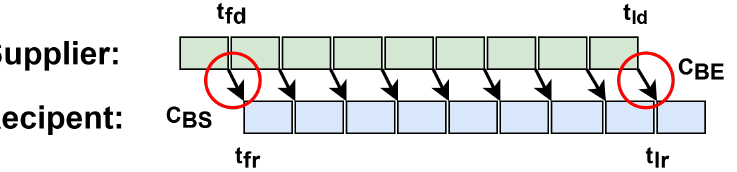
Figure 1. Control points of the components C BS and C BE for two technological operations in the relationship between the supplier and the